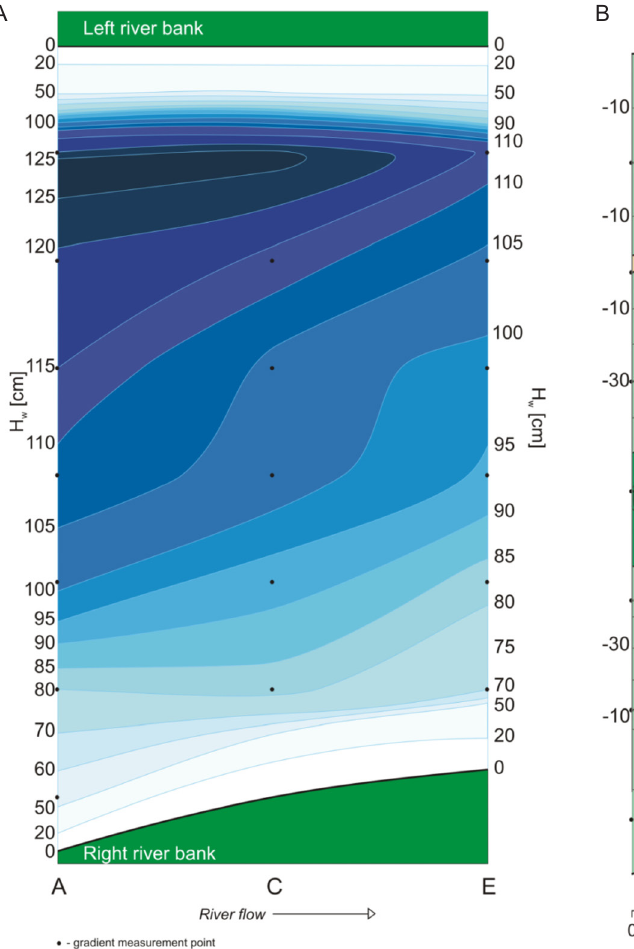
Fig. 10. Hydraulic gradient changeability in the river bottom during high water